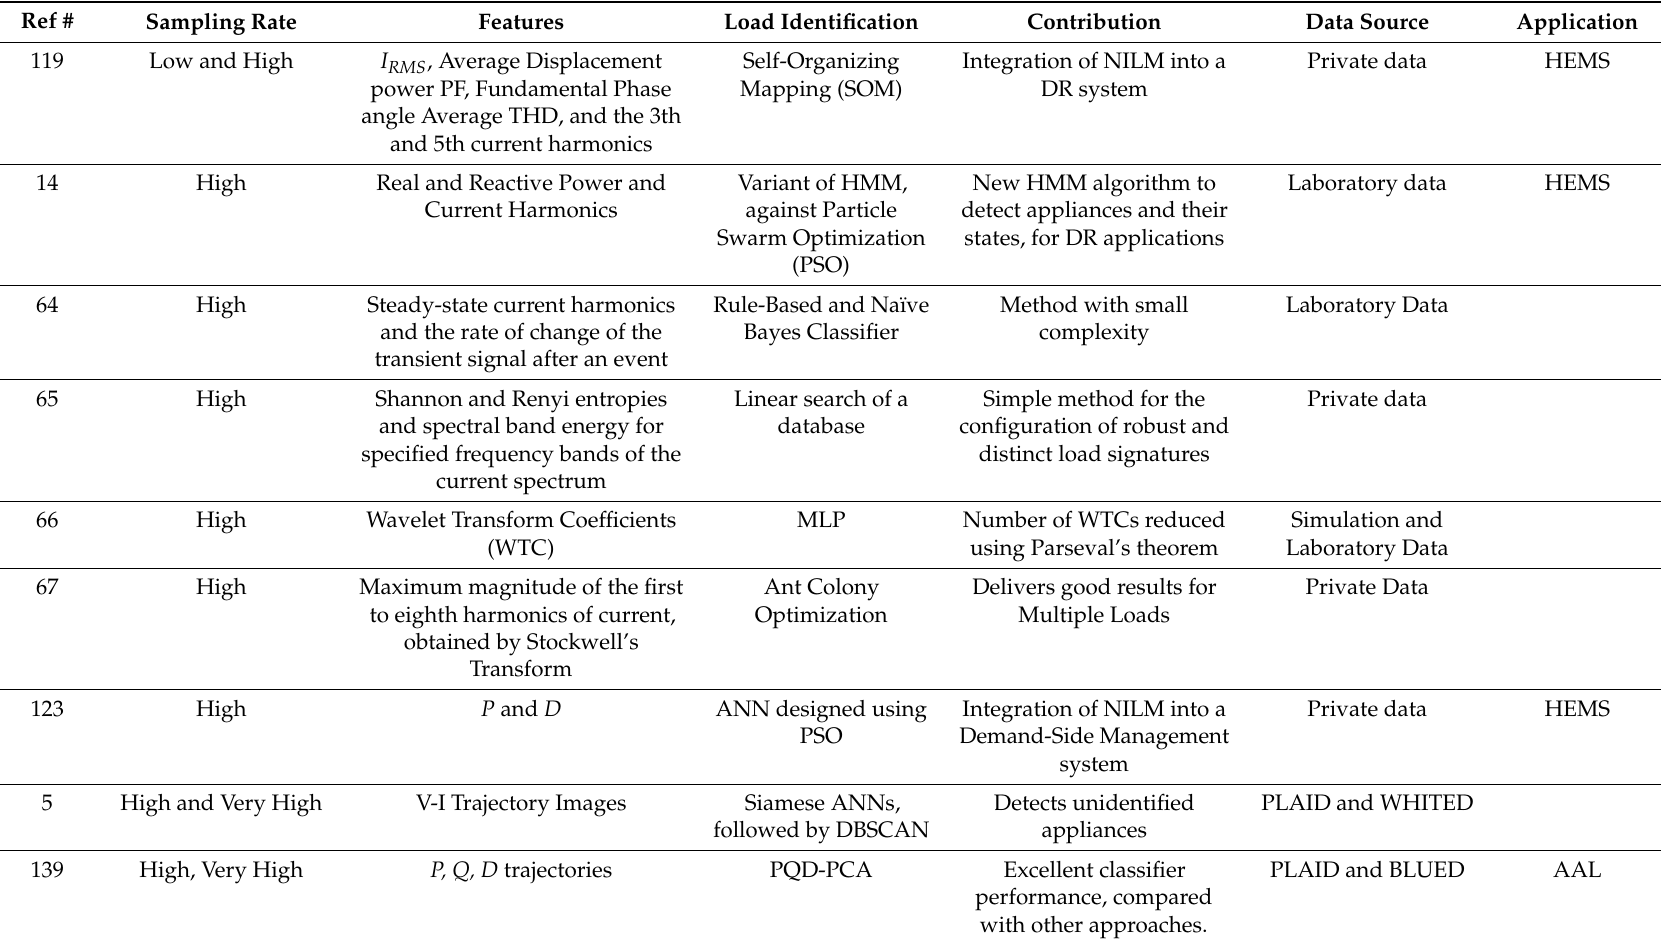
Table A2. Main characteristics of selected NILM techniques with high, very high and extremely high sampling